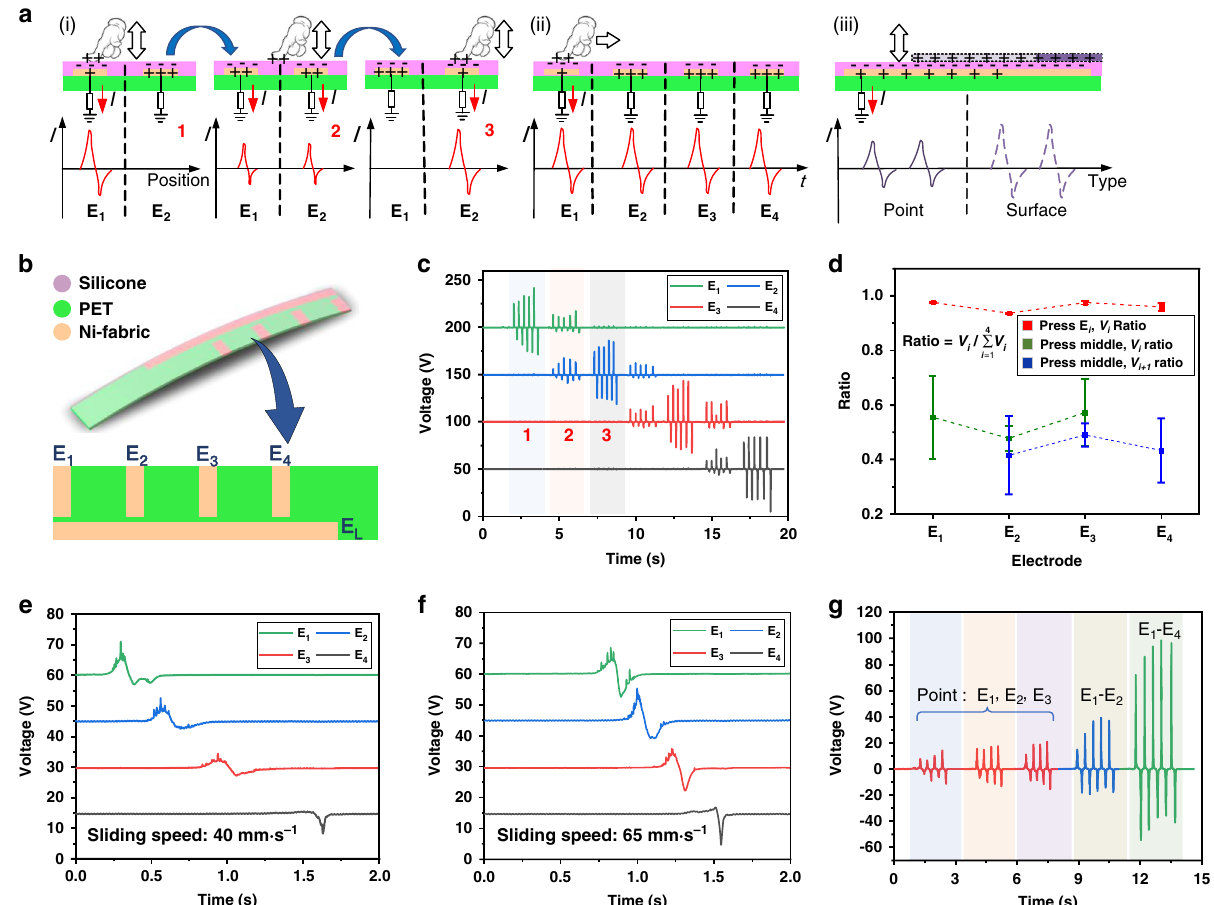
Fig. 2 Working mechanism and characterization of the tactile TENG (T-TENG) sensor. a Operation mechanism of the T-TENG sensor used for various functions including (i) contact position detection, (ii) sliding detection, and (iii) contact mode recognition. b Schematic diagram of the distribution of the electrodes. The short electrodes are marked as E 1 to E 4 and the long electrode is marked as E L . c Output signals of E 1 to E 4 by tapping different positions across the T-TENG sensor patch in point-contact mode. d Voltage ratio analysis of the result in c , where V i means the voltage of the i th electrode. Sliding test at the speed of e 40 and f 65 mm·s − 1 . g Output signals of E L when tapped with different contact